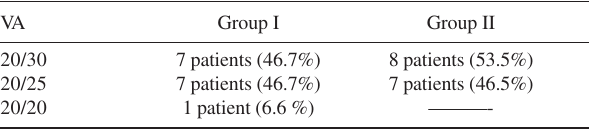
Table 2 - Best Spectacle-Corrected Visual Acuity